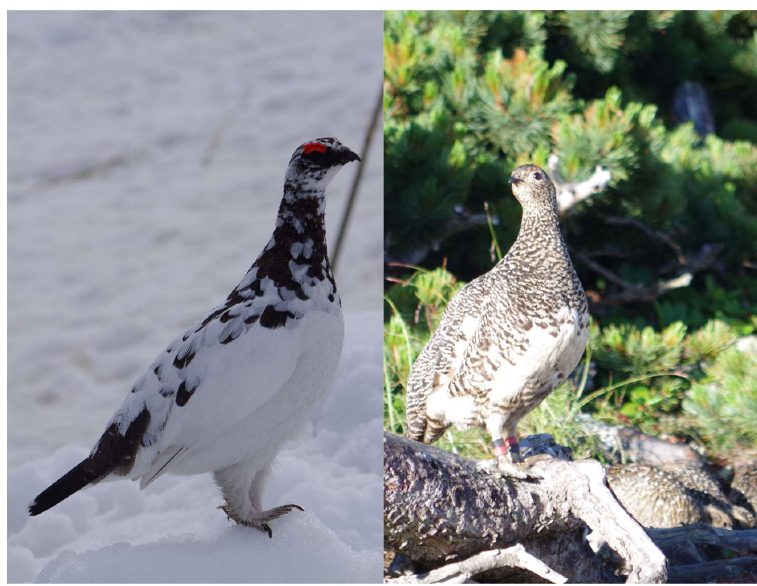
Figure 2. Japanese rock Ptarmigan ( Left : A male Japanese rock Ptarmigan on the unmelted snow at Mt. Tateyama in spring. Right : A female Japanese rock ptarmigan with her chicks at Mt. Kita in